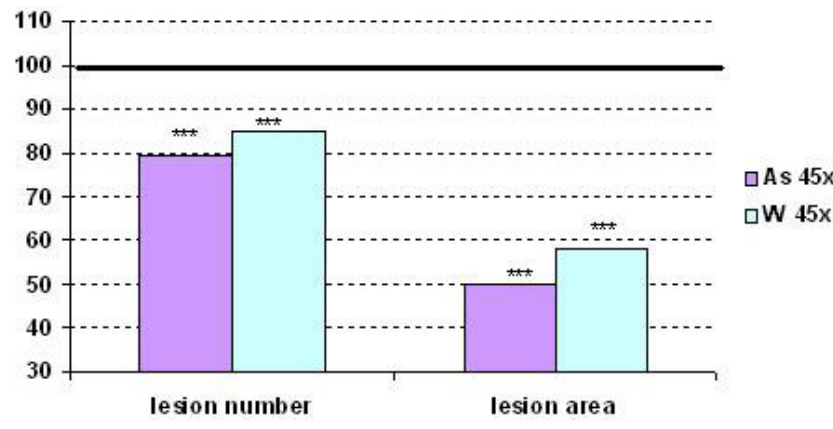
FIGURE 9 . Tobacco/TMV model; hypersensitive lesion number and area